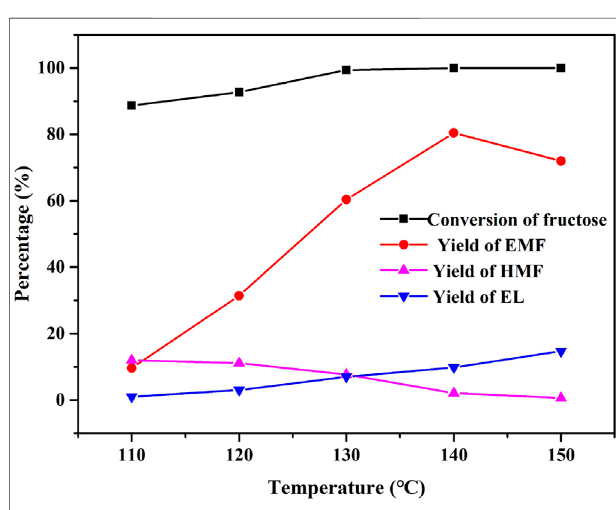
Figure 7 . As the reaction temperature was 110 ° C, the yield of